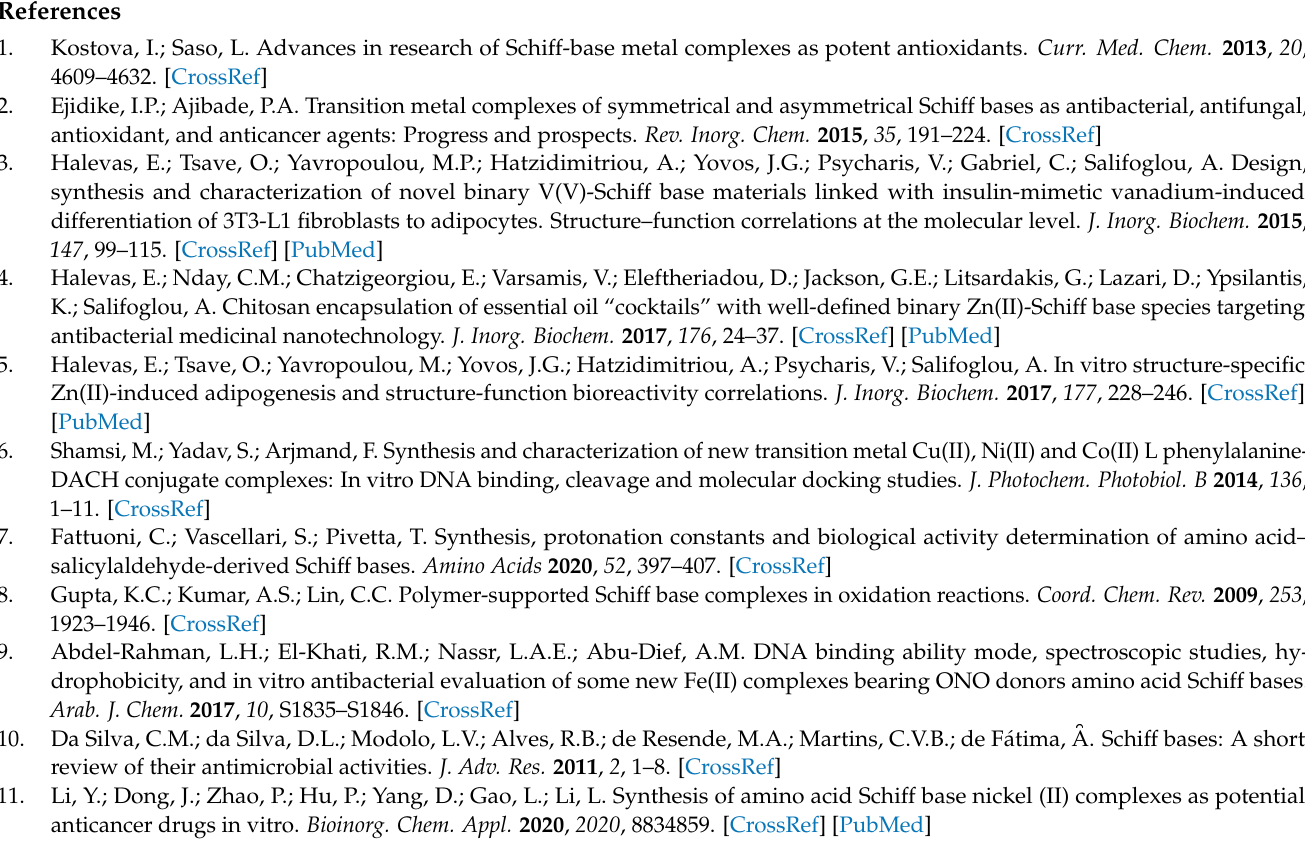
Table S2: Summary of crystal, intensity collection and refinement data for [Cu(C 12 H 14 NO 4 ) 2 ] n · nO ( 4 ). Figure S1. 1 H-NMR spectrum of compound 3 in DMSO- d 6 . Figure S2. 13 C-NMR spectrum of compound 3 in DMSO- d 6 . Figure S3. 1 H- 1 H COSY spectrum of compound 3 in DMSO- d 6 . Figure S4. 1 H- 13 C HMBC spectrum of compound 3 in DMSO- d 6 . Figure S5. 1 H- 13 C HSQC spectrum of compound 3 in DMSO- d 6 . Figure S6. 1 H- 1 H NOESY spectrum of compound 3 in DMSO- d 6 . Figure S7. FT-IR spectra of Schiff base 3 and complex 4 . Figure S8. HRMS Spectra of the Schiff base 3 . Figure S9. HRMS Spectrum of the complex 4. CCDC 2051769 (4) contains the